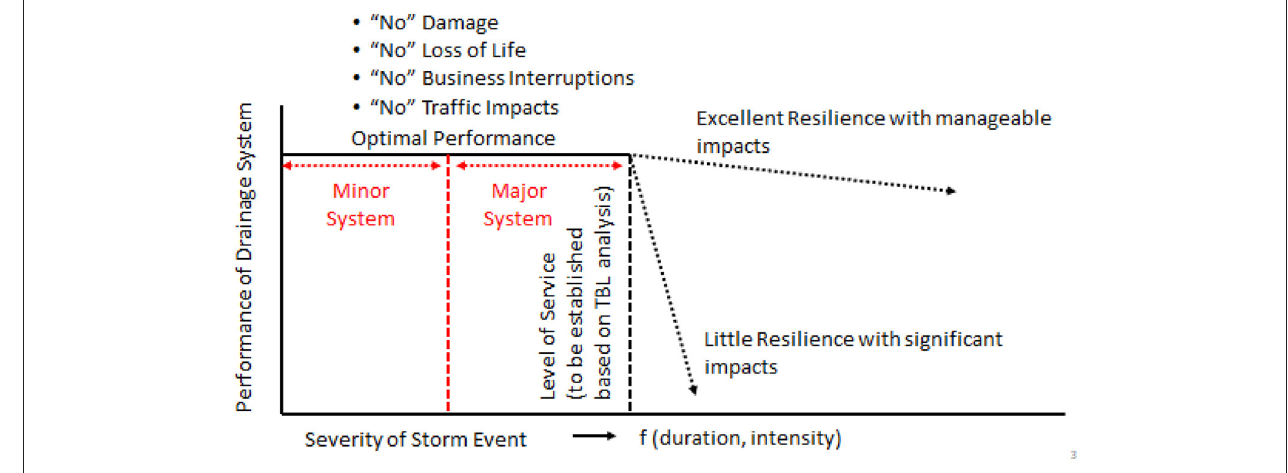
FIGURE 1 | Flood Control Performance of Dual Drainage System.